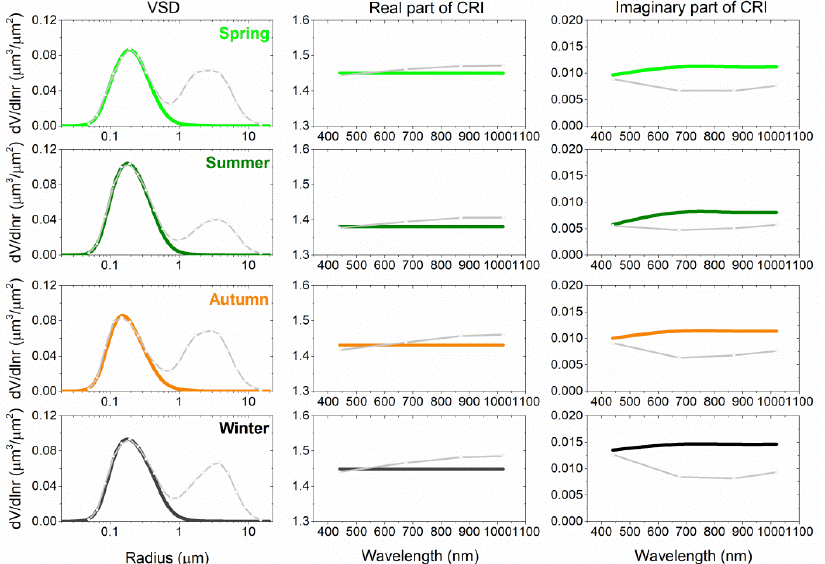
Figure 5. Seasonal variation of fine-mode volume size distribution (VSD) and complex refractive index (CRI) in SONET Chengdu site. The grey line refers to the total parameters. The corresponding parameters are listed in Table 2.